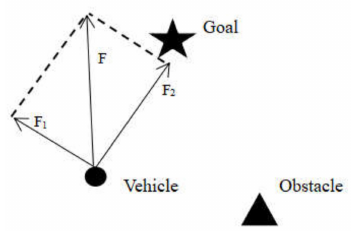
Figure 1. Force analysis of moving vehicle in artificial potential